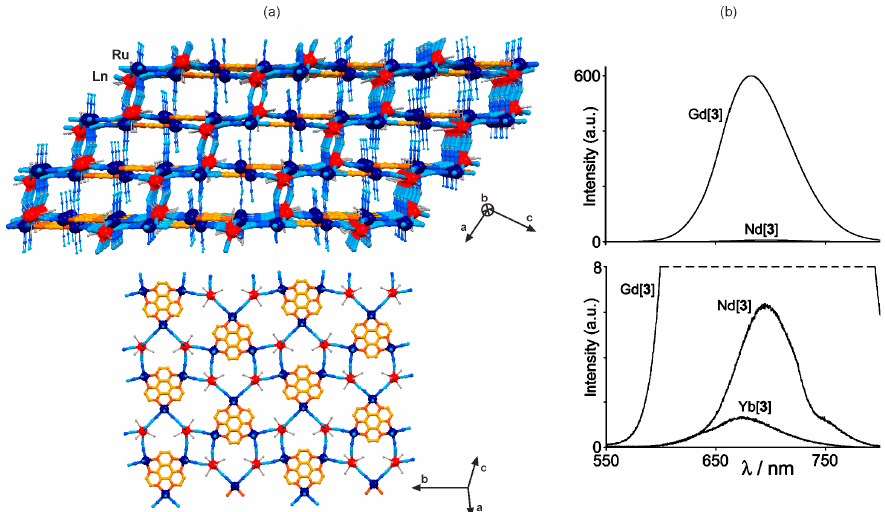
Figure 10. Crystal structure and optical properties of three-dimensional [Ln III (H 2 O) 4 ] 2 [{Ru II (CN) 4 } 3 (HAT)]·13H 2 O 4 (Ln = Nd, Gd, Yb; HAT = hexaazatriphenylene) coordination networks: ( a ) the view of the whole network along the b crystallographic direction, and the detailed view of the layered fragment of the 3D network situated within the (101) plane, ( b ) the lanthanide-dependent room temperature emission spectra in the visible range. Colours for the structural diagram: Ln, red; Ru, dark blue; CN − , blue; HAT, orange; H 2 O, grey [116]. Reprinted with permission from J. Am. Chem. Soc. 2007 , 129 , 11491–11504. Copyright 2007 American Chemical Society.